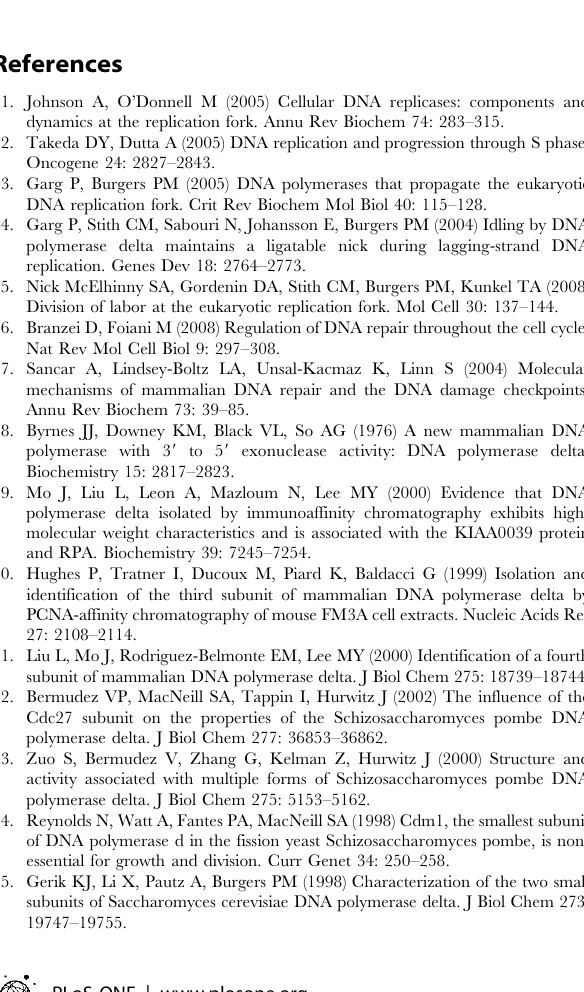
Figure S2 Purification of recombinant pol d heterote- tramer by Mono Q chromatography from pellet fraction of hemolymph. The peak fractions from the immunoaffinity chromatography step in which the column was applied with pellet fraction of infected larvae hemolymph were combined and passed through a Mono Q column. The lysates (BC) and the eluted fractions were analyzed by 12.5% SDS-PAGE followed by Coomassie Blue staining. Pol d four subunits are marked by arrows.